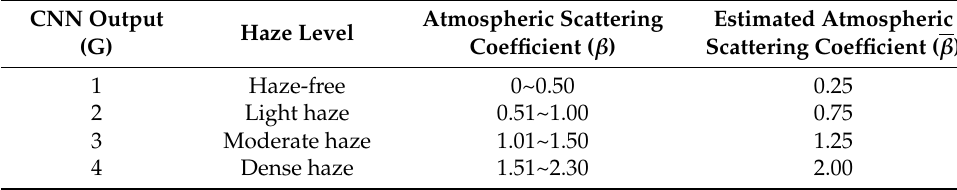
Table 1. Estimated atmospheric scattering coefficients by haze